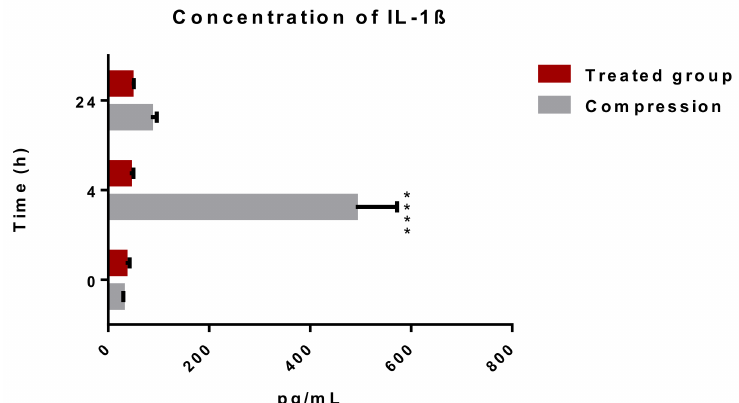
Figure 1. Concentration of pro-inflammatory cytokine IL-1 β in the blood serum after a traumatic SCI and the ATR treatment. A significant elevation of IL-1 β was noted 4 h after the SCI. ATR applied in a single dose (5 mg/kg; i.p.) immediately after the SCI reduced the release of IL-1 β after 4 and 24 h. Data are the mean values of eight experiments ± SD. The results were statistically evaluated using two-way analysis of variance (ANOVA) and post hoc Tukey’s HSD test; **** p <